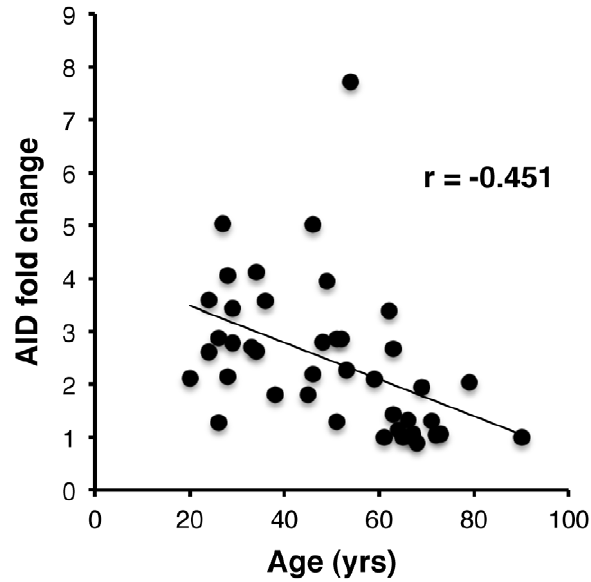
Figure 1. AID response following H1N1pdm09 vaccination declines in age-dependent manner. PBMC (10 6 cells/ml), were isolated from 42 individuals before (t0) and after H1N1pdm09 vaccination (t28), and were cultured with vaccine for 7 days. At the end of culture, cells were processed as described in Materials and Methods. Results are expressed as qPCR value fold-increase in AID mRNA expression (normalized to GAPDH mRNA) after vaccination compared with the age of the vaccinated individuals. The fold-increase in AID mRNA expression after vaccination is calculated as follows: qPCR values after H1N1pdm09 vaccination/qPCR values before vaccination. AID fold change $ 2 is considered meaningful. A statistically significant negative correlation coefficient was observed between levels of AID induction with increase in age. Representative of two experiments.